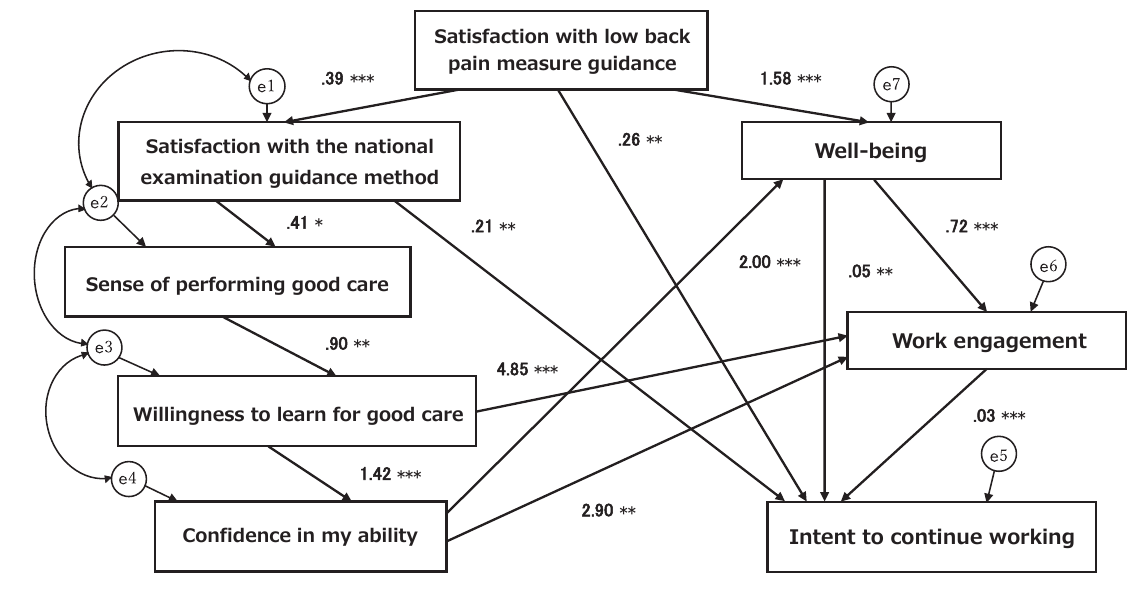
Fig. 2 E ff ect of various factors on intent to continue working: modi fi ed